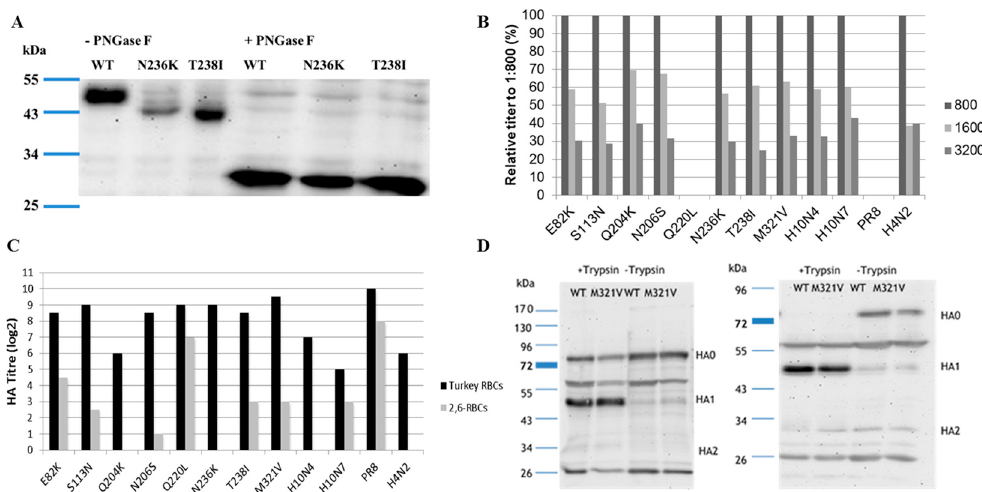
Figure 2. ( A ) Molecular weight of the HA of H10N4 (wild type) compared to viruses carrying N236K or T238I without (-PNGase) or with (+PNGase) treatment using PNGase F; ( B ) affinity of different recombinant H10 viruses to avian-type receptors using different concentrations (1:800; 1:1600, and 1:3200) of 2,3-labelled fetuin analyzed in solid-phase assay; ( C ) receptor binding affinity to turkey erythrocytes expressing both avian and mammalian sialic acid receptors, and modified turkey erythrocytes expressing 2,6-mammalian receptors only. Results are expressed as average of hemagglutination titer of two independent runs, each run in duplicate; ( D ) cleavage of HA of H10N4 compared to H10N4 with M321V substitution in the presence (+Trypsin) or absence (-Trypsin) of trypsin 6 or 24 h after infection of Madin-Darby canine kidney cells type II (MDCKII) using polyclonal antiserum generated 10 days after intravenous inoculation of chickens with H10N4 virus. All viruses were constructed by reverse genetics, except H10N7 wild-type virus, which was used as a control.